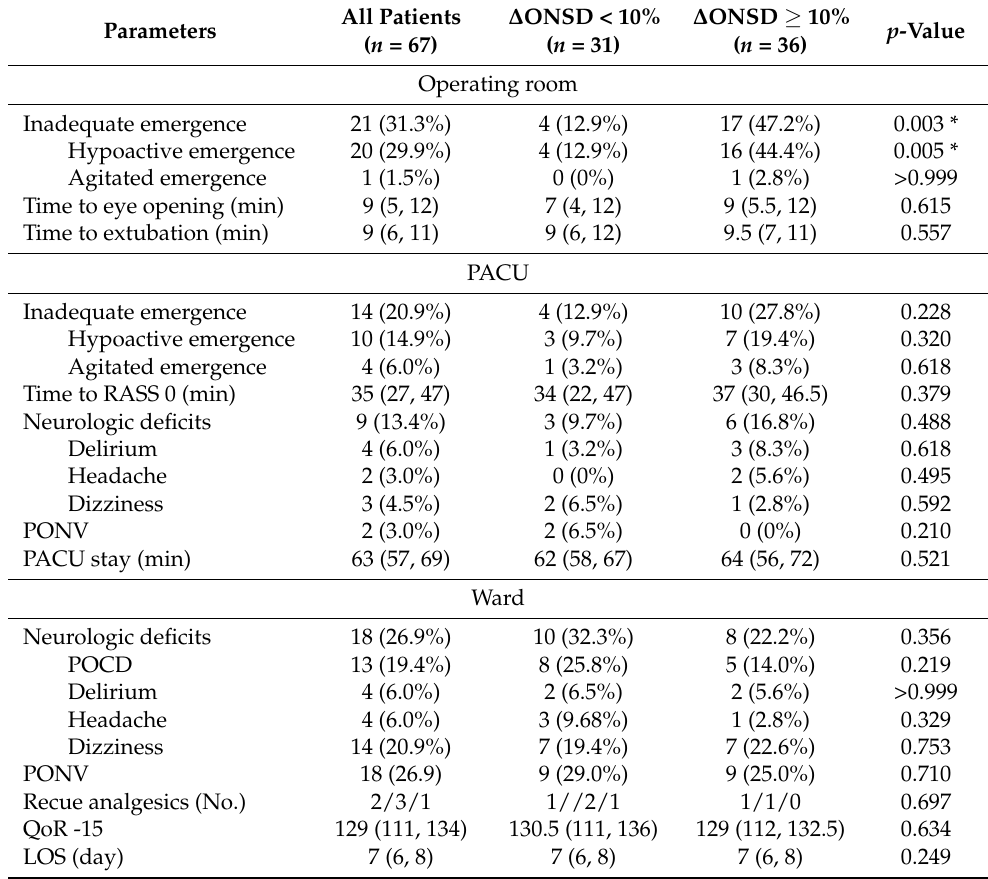
Figure 4. RASS score in OR and upon PACU arrival. ( A ) RASS score in OR; ( B ) RASS score upon PACU arrival. RASS, Richmond Agitation-Sedation Scale. Table 3. Composite variables to assess the quality of emergence and neurologic deficits.